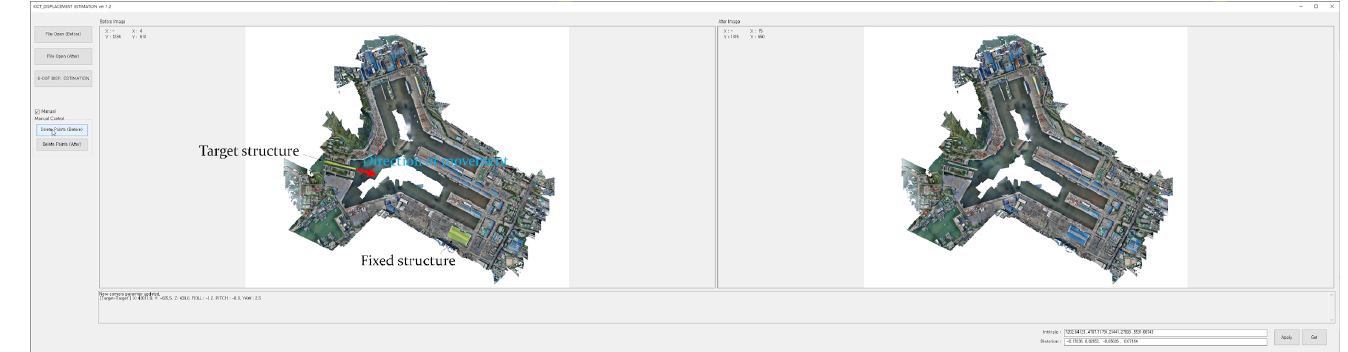
Figure 9. Estimation of the relative displacement using port structure